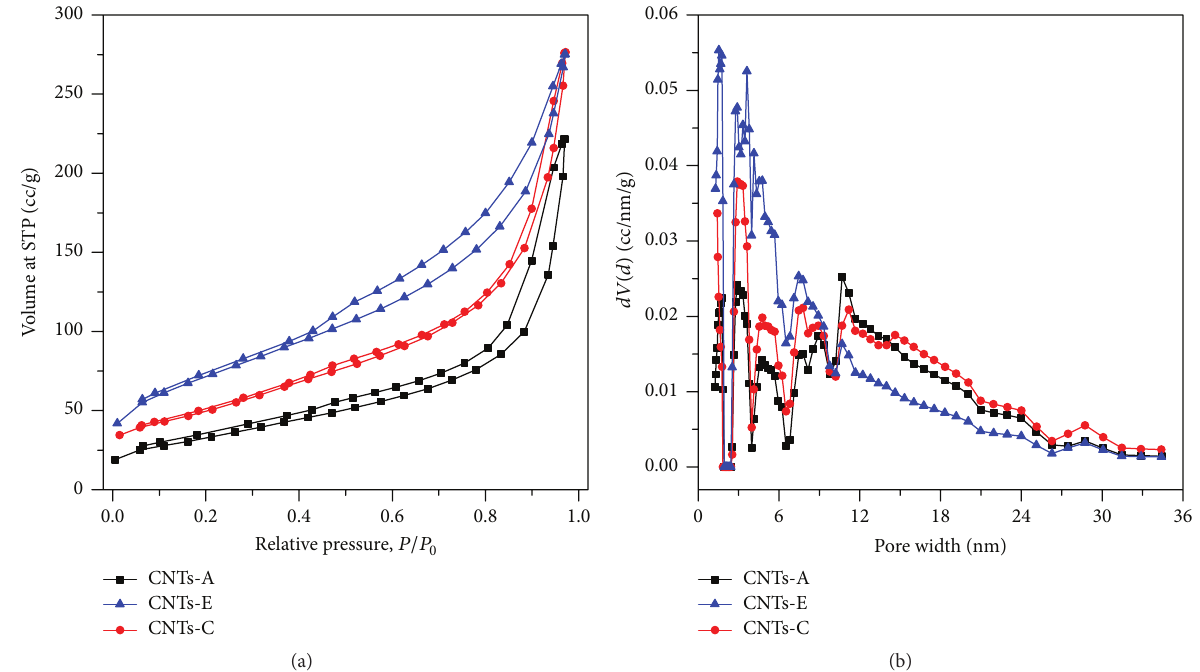
Figure 1: N 2 adsorption/desorption isotherms (77K) (a) and pore size distributions (b) obtained applying the DFT equation corresponding to the CNTs samples.